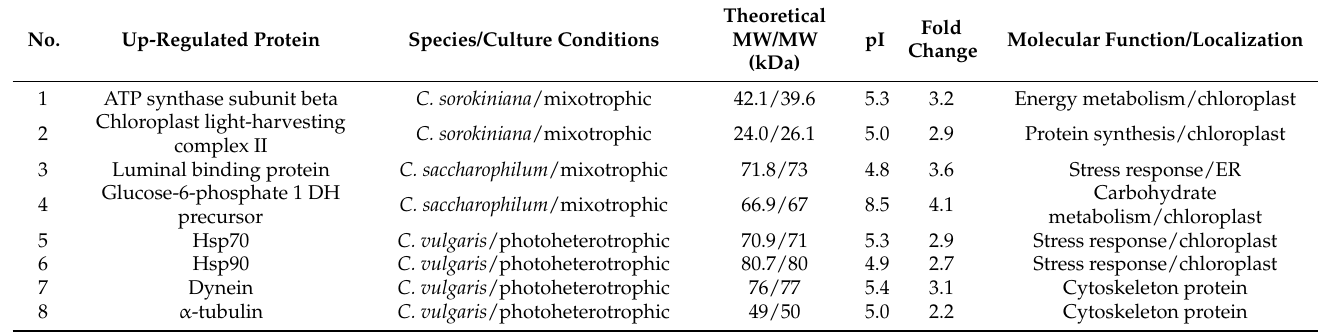
Table 2. Characteristics of up-regulated proteins induced photoheterotrophically and mixotrophically in the culture of C. sorokiniana , C. saccharophilum , and C. vulgaris